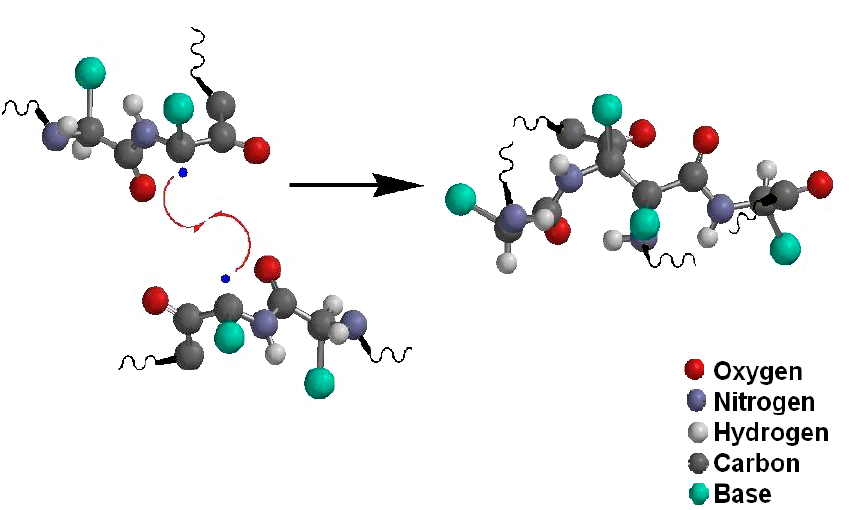
Figure 3. Oxidation mechanism in proteins.